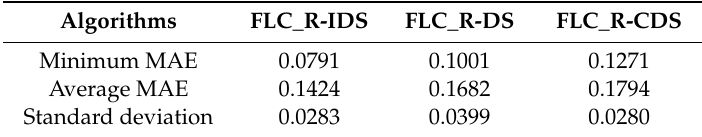
Table 6. Comparison of 30 controllers and their MAE values of various existing models in test environment 3.